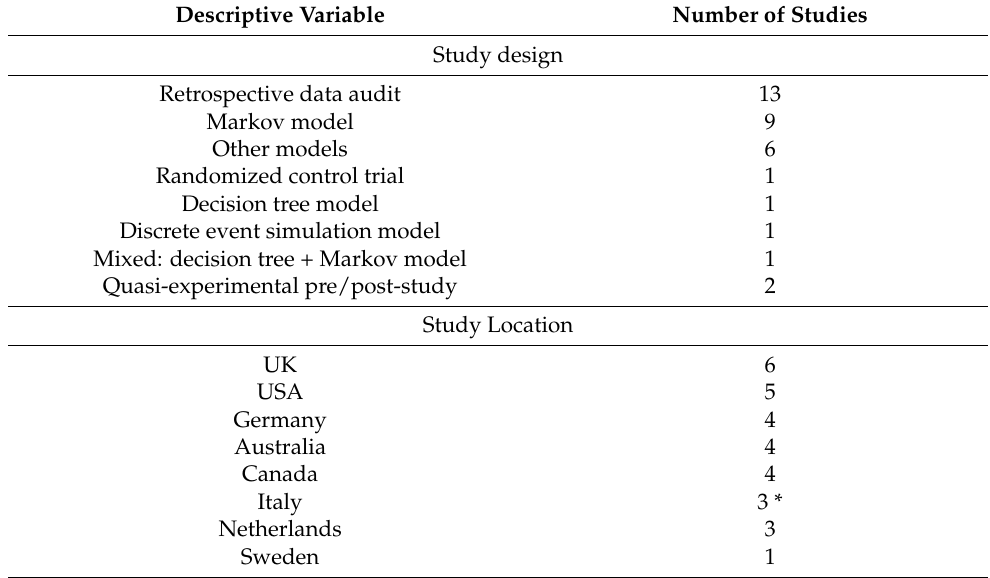
Table 1. Descriptive information of included studies .